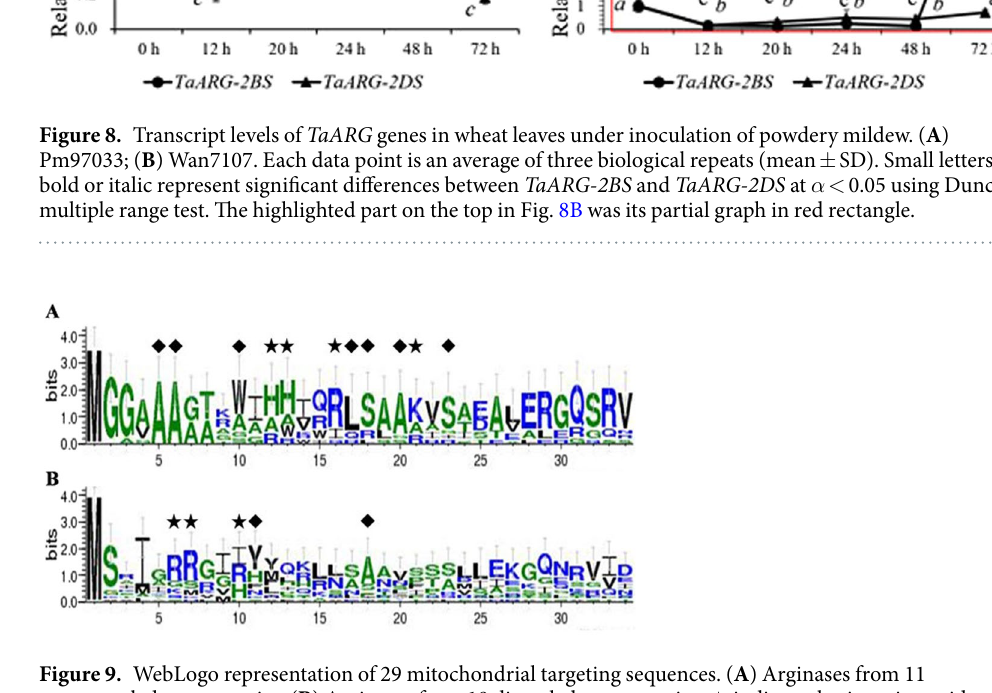
Figure 9. WebLogo representation of 29 mitochondrial targeting sequences. ( A ) Arginases from 11 monocotyledonous species; ( B ) Arginases from 18 dicotyledonous species: ★ indicates basic amino acid residues conserved in over 50% of sequences; ◆ indicates hydrophobic amino acid residues conserved in over 60% of